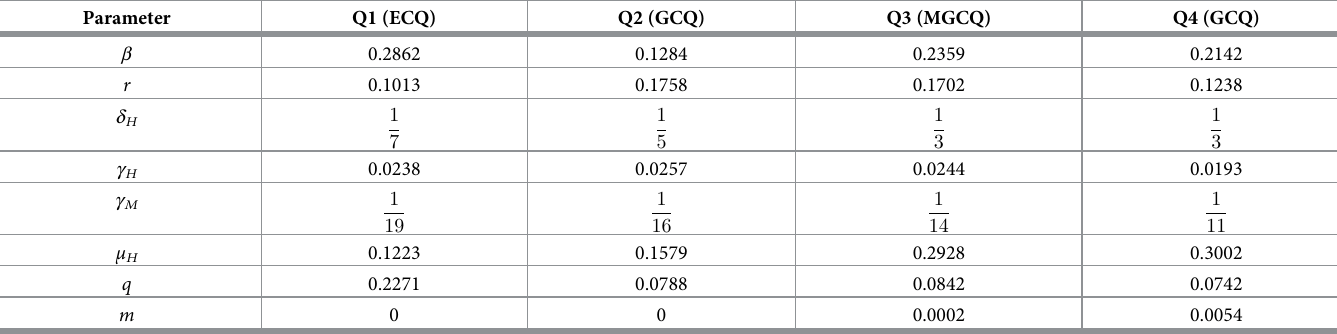
Table 3. Estimated parameter values per quarantine period for Davao City,